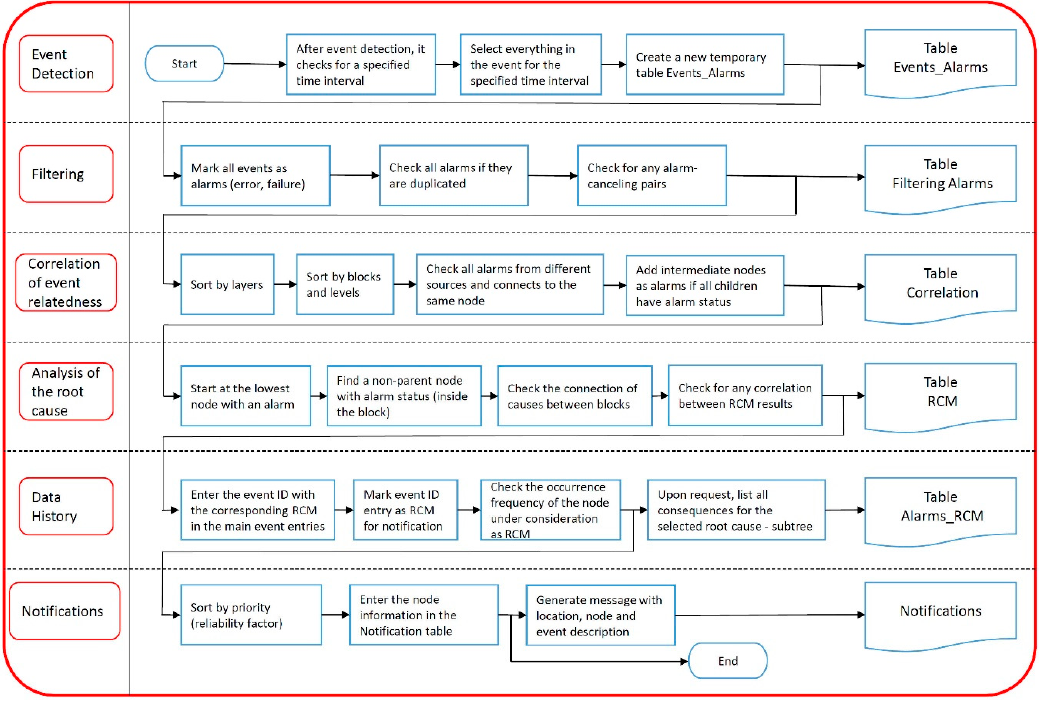
Figure 6. Key steps of event processing.